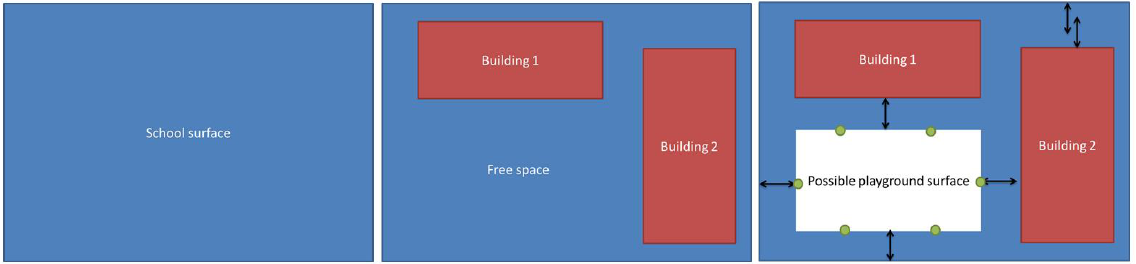
Figure 4: Construction of the source points for the presence of children’s voices in schools at recreation times.